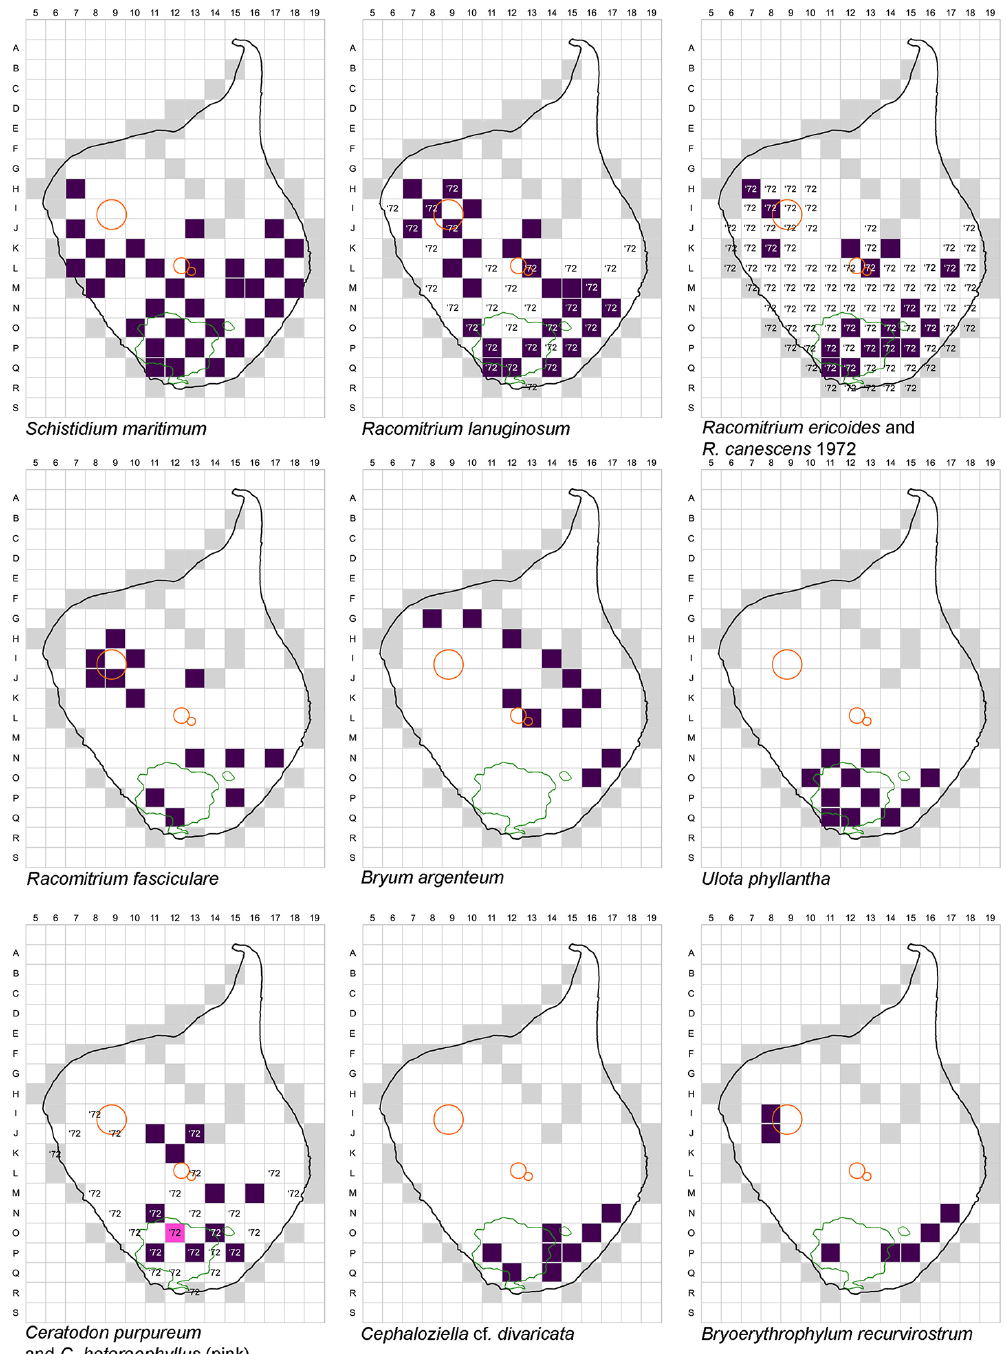
Figure 4. Distribution maps for the most widespread bryophyte species found in 2008, compared with distribution in 1972 when applicable. Ceratodon heterophyllus is included in a different colour (pink). Orange circles indicate the craters and the green contours indicate the seagull colony area with dense vegetation. Grey quadrats indicate inaccessible areas; the contour of Surtsey is from 2010; each quadrat is 100m × 100m. Maps: Anette Meier and